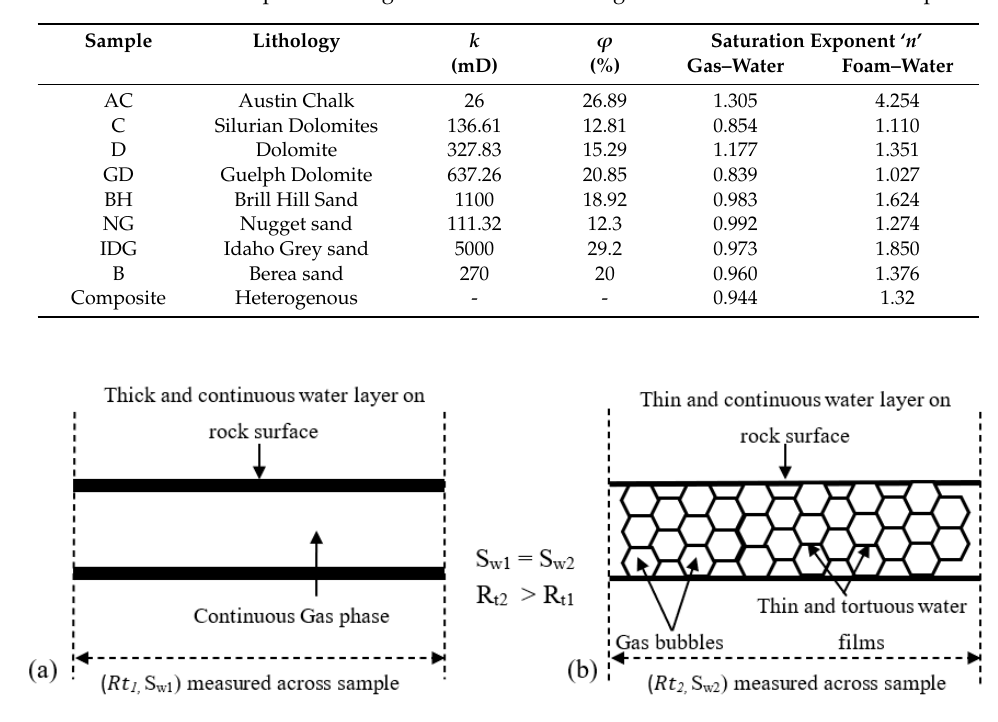
Figure 9. Illustration of electrical resistivity for: ( a ) Gas–water system; ( b ) foamed gas–water system. Foam appears to a ff ect the connectivity and electrical resistivity of a porous medium in a similar way to wettability, as studied by Liu et al. [31]. Foam like oil wetness can increase the value of the Table 1. Saturation exponents for gas–water and foamed gas–water in different rock samples. saturation exponent at lower water saturation, when the water film becomes thin, tortuous, and sometimes